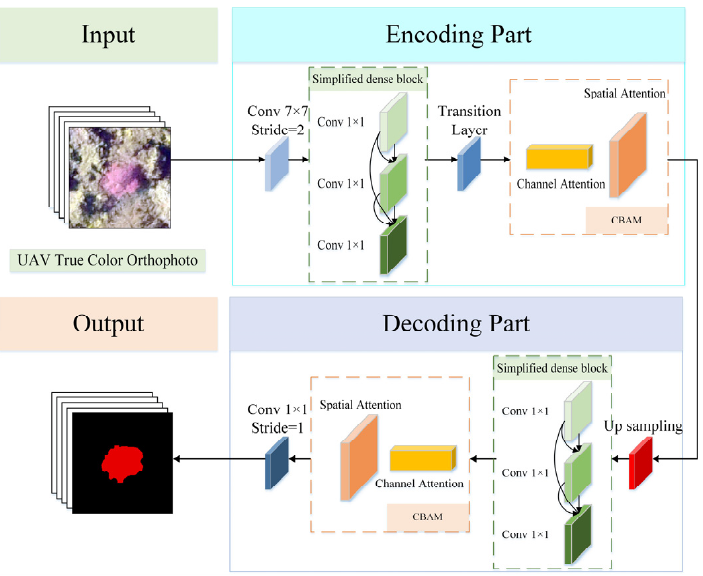
Figure 5. D-SCNet network